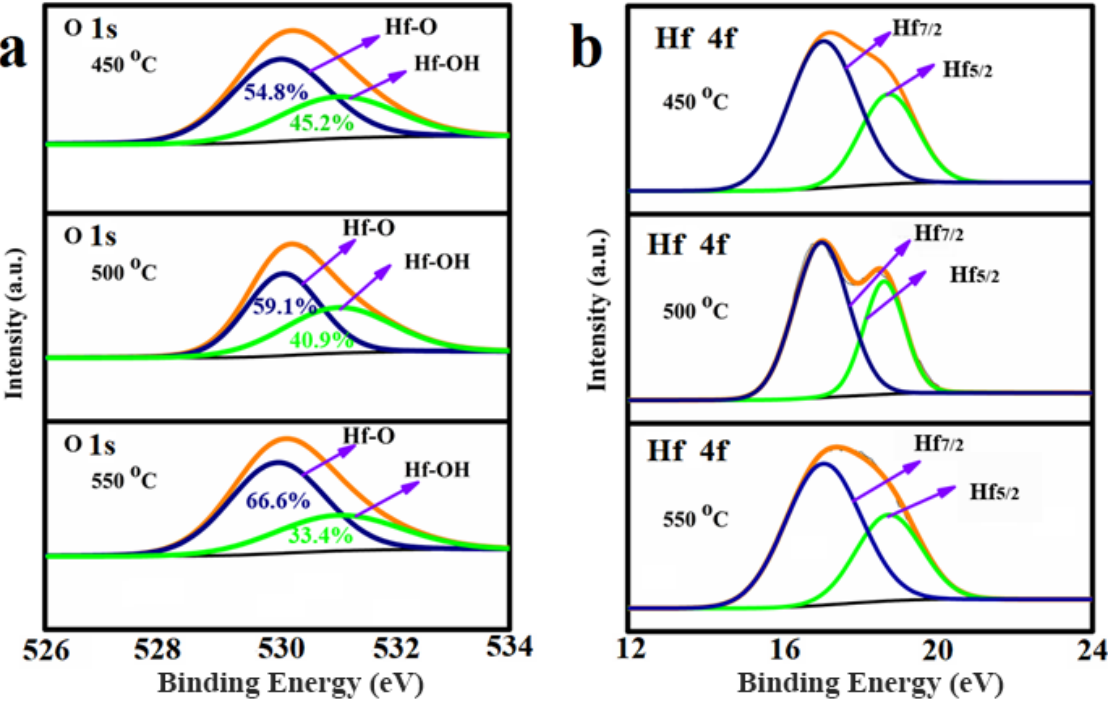
Figure 3. ( a , b ) XPS spectra of O 1s and Hf 4f peaks for HfO 2 thin films as a function of annealing temperature.